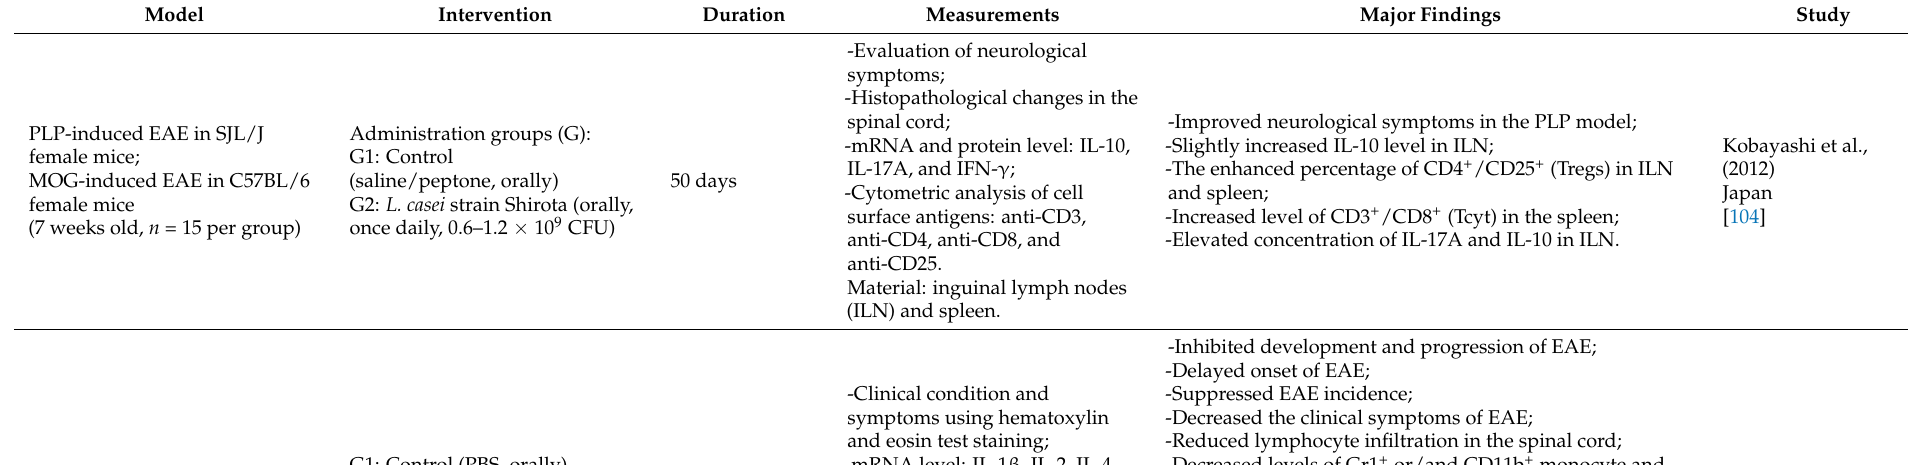
Table 2. Effect of probiotic supplementation on different EAE animal